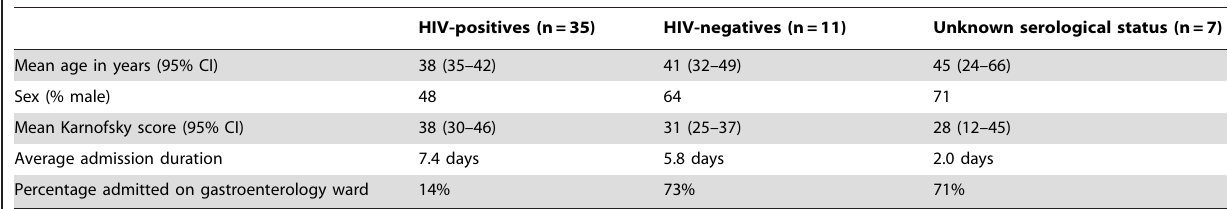
Table 1. Patient characteristics (n=